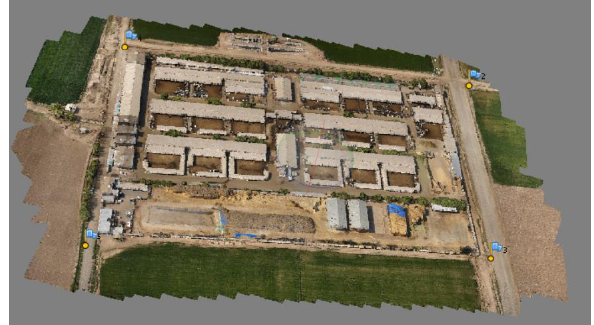
Figure 8: 3D dense reference